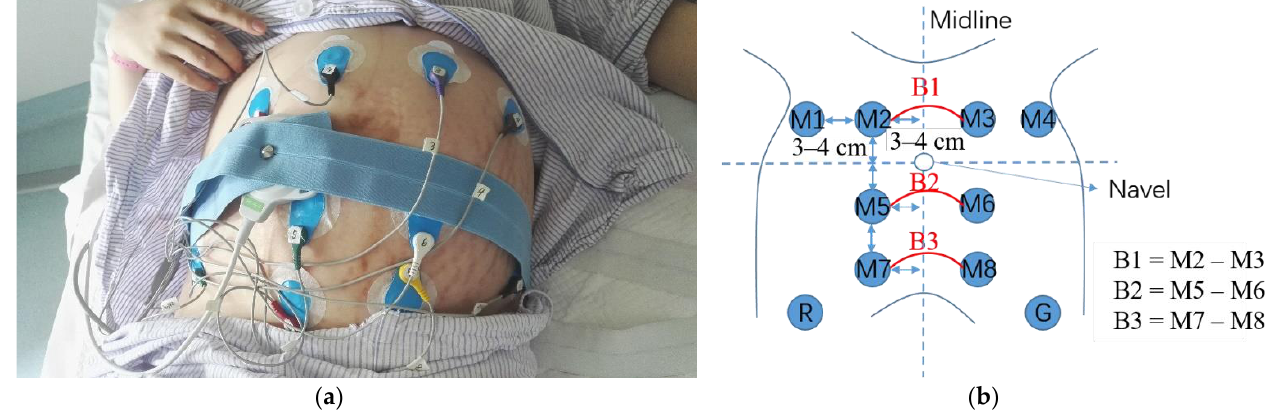
Figure 2. Signal recording ( a ) Electrodes on the abdominal surface of a pregnant woman; ( b ) Bipolar signals obtained from the monopolar recordings.